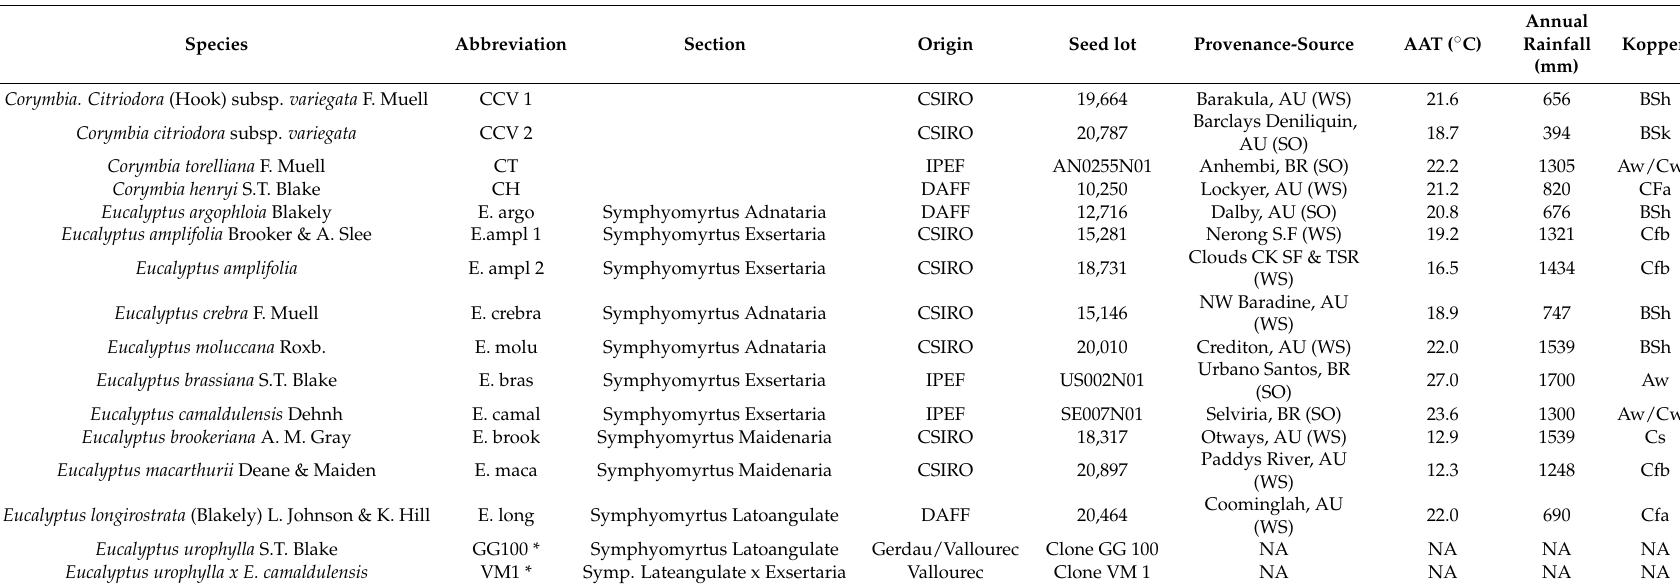
Table 1. Studied taxa of Corymbia and Eucalyptus with their respective abbreviation, section, origin, seed lot, and provenance-location with respective